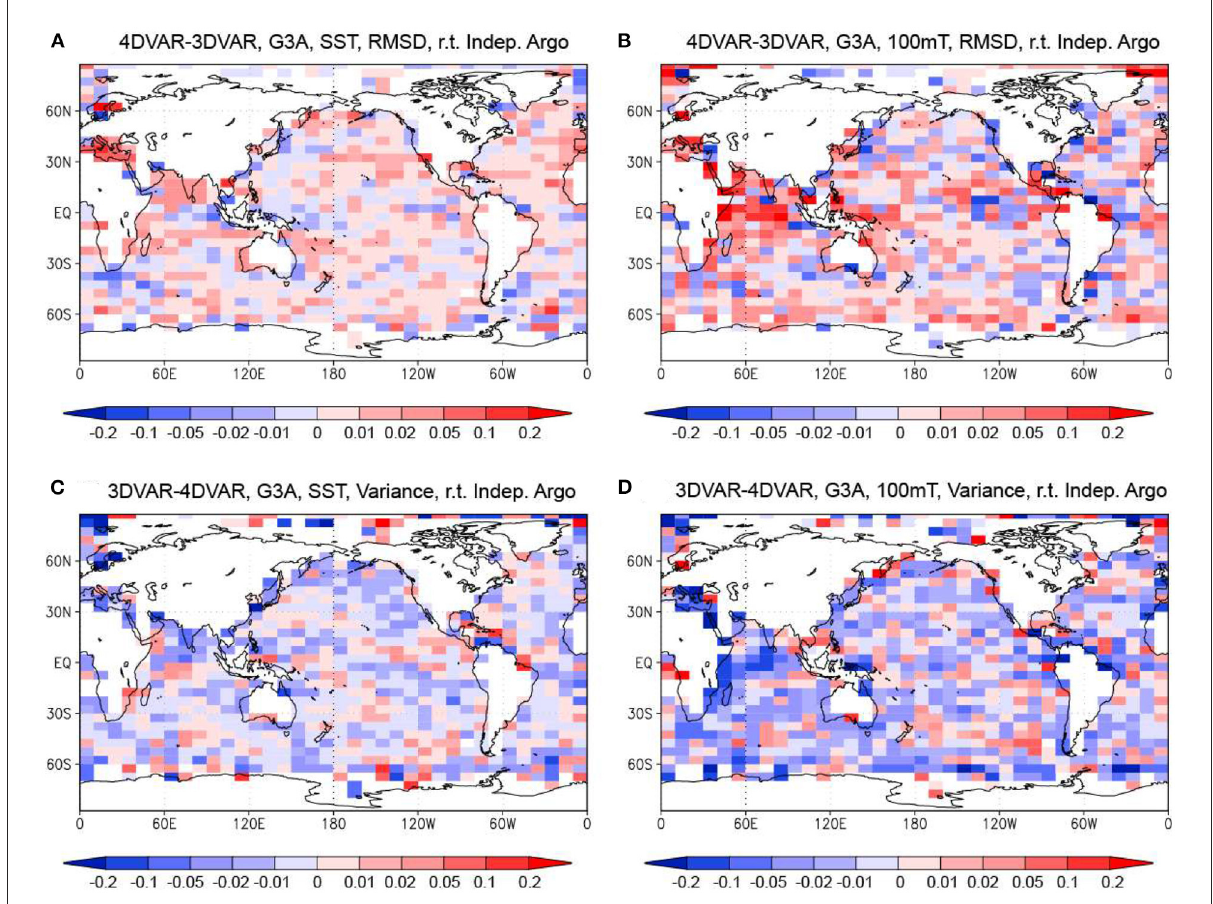
FIGURE6 Difference of the RMSDs and the relative standard deviations of the MOVE-G3A temperature relative to the independent Argo float data between the 4DVAR and 3DVAR Runs. (A, B) Difference of the RMSDs at the surface and the 100m depth. (C, D) Difference of the relative standard deviations at the surface and 100m depth. Blue colors mean that the RMSD is smaller for the 4DVAR Run in (A, B) , and that the relative standar deviation is larger for the 4DVAR Run in (C, D) . Units in ◦